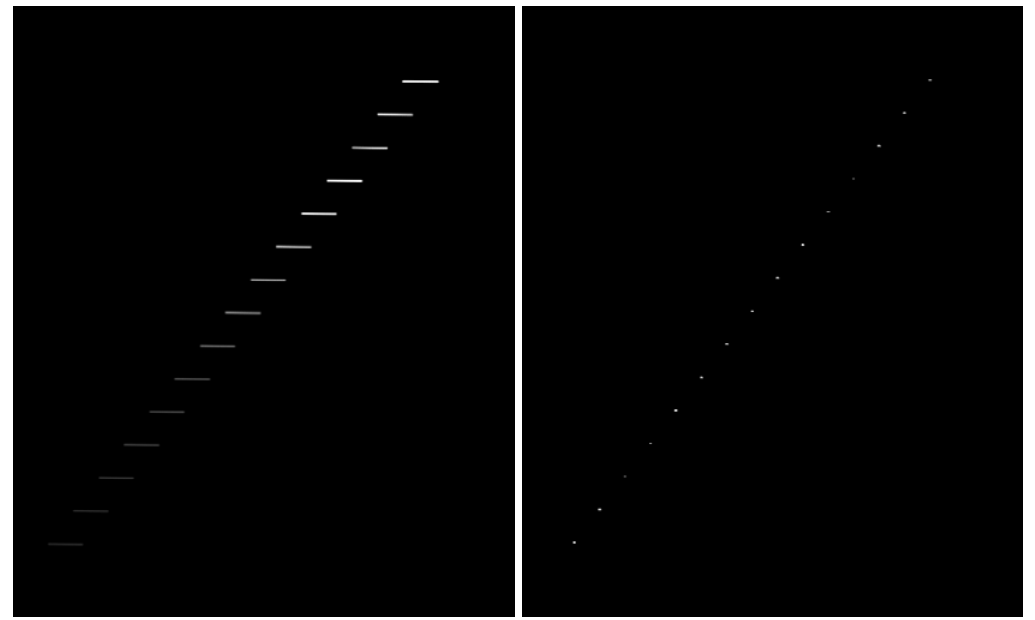
Figure 4. Simulated image of a collection of satellites (left) and its AWMLE deconvolution (right) using the trace of the brightest satellite as PSF. Both panels are displayed using the same grey scale distribution. The global flux of every trail is preserved in right panel while intensity distribution is compressed into much less